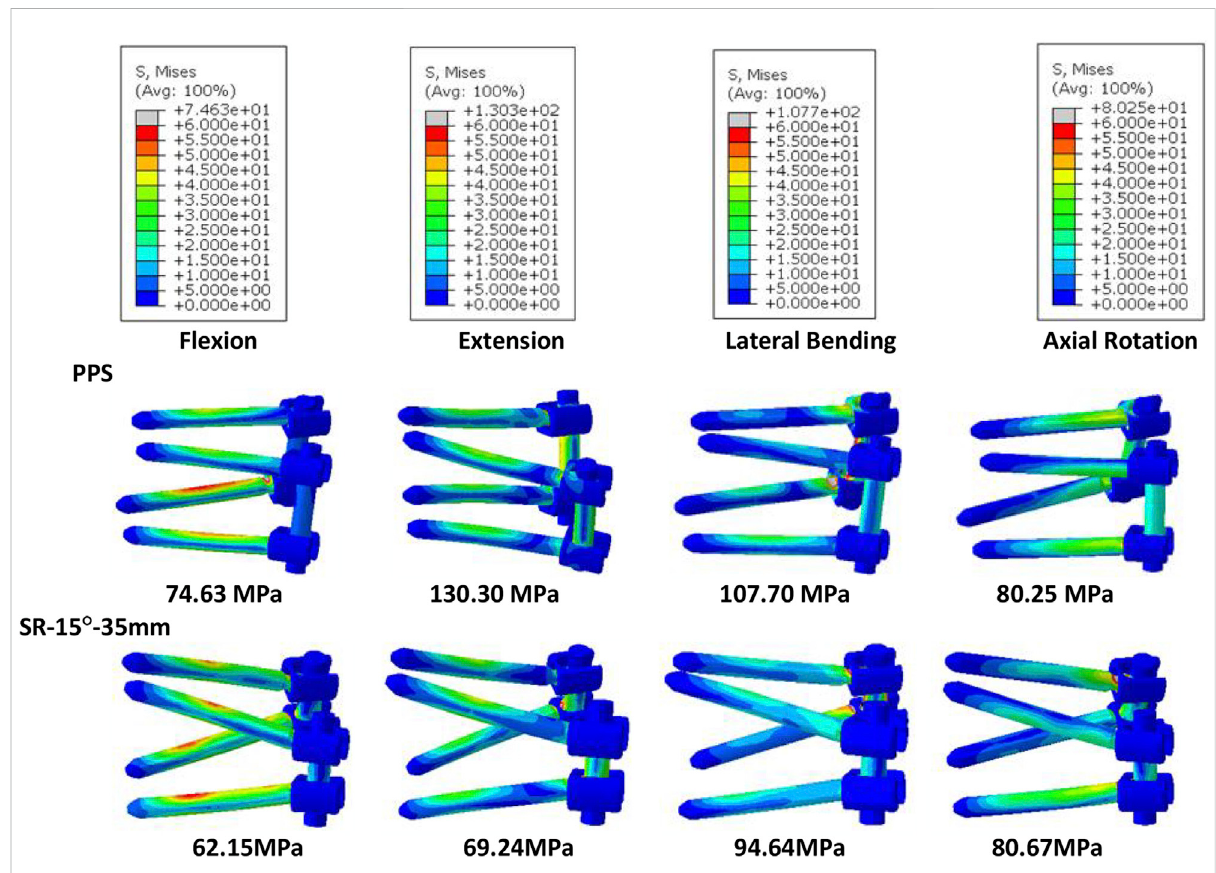
FIGURE 11 Von-Mises stress on screws of the PPS model and SR model, with the peak stress noted beneath each